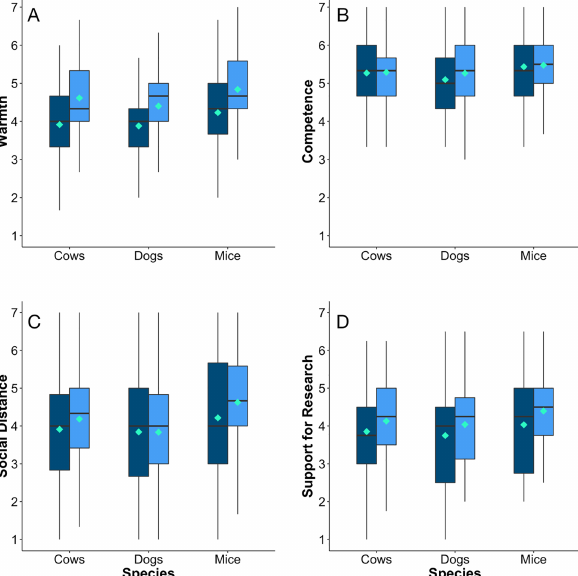
Fig 1. Responses by participants asked questions designed to assess a) warmth, b) competence, and c) social distance for the hypothetical lab animal technician “Cathy,” as well as d) support for the research she does. Participants were randomly asssigned to scenarios that described Cathy as working at either a low (dark blue) or high transparency (light blue) institution, using three different species of research animal (cows, dogs and mice). All individual questions were asked on a 7 point Likert-type scale (1 = not at all; 4 = neutral, 7 = extremely); responses for each of the composite measures shown below were averaged across individual questions. The box plots show the mean (central square), median (solid horizonal line in the middle of the box), 25 th and 75 th percentiles (the upper and lower limits of the box) and 10 th and 90 th percentiles (verticle lines extenting above and below the box).